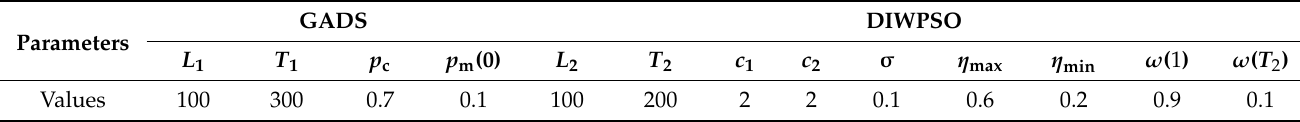
Table 6. Hybrid algorithm parameter setting.